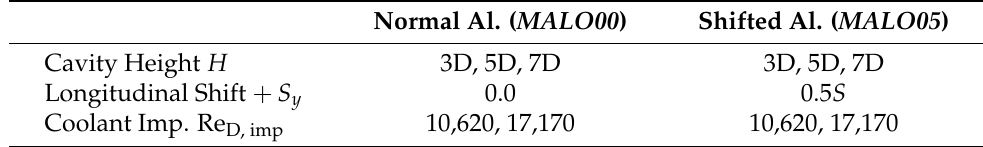
Table 1. Overview of geometrical test configurations.